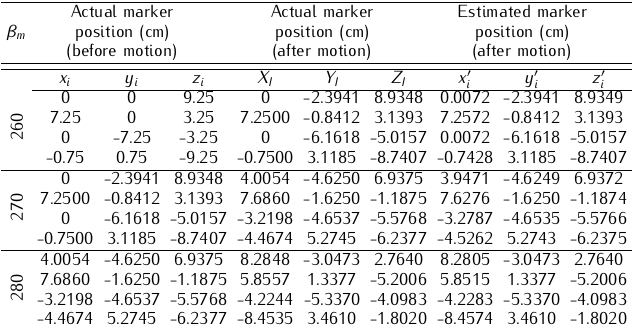
Table 9. Estimated Markers Coordinates after Rotational Motion. Table 10.